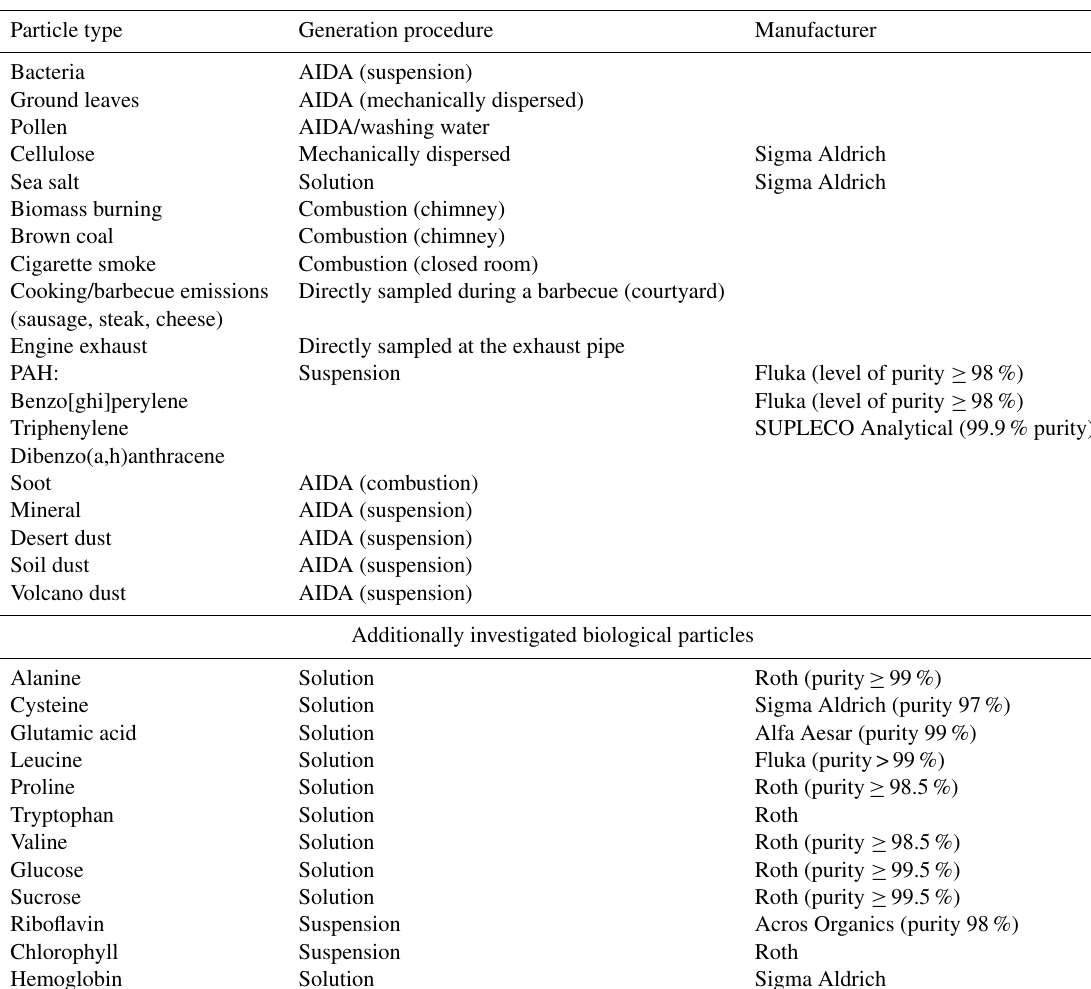
Table 1. Investigated particles types with the corresponding generation procedure, manufacturer and purity where applicable data. Particle